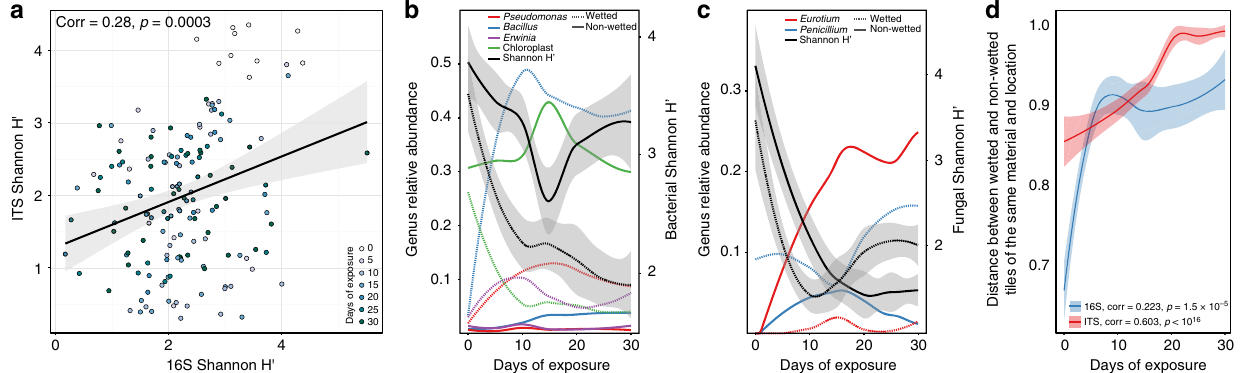
Fig. 3 Overview of community succession. a Fungal diversity and bacterial diversity are signi fi cantly correlated across communities ( n = 153 samples). Points represent individual samples, colored by the time point at which the sample was taken. b Changes in the relative abundance of selected bacterial genera over the course of succession ( n = 338 samples). Lines represent a smoothed moving-average of the mean. Genus is indicated by color and wetting condition is indicted by line style. Average community diversity (Shannon H ′ at OTU level, as in Fig. 3) is indicated by black lines with standard error indicated by the gray-shaded region. Genus abundance is indicated on the left y -axis and Shannon H ′ is indicated on the right y -axis. c Changes in the relative abundance of selected fungal genera over the course of succession ( n = 330 samples). Formatting is as in b . d Wet vs. nonwetted replicates of coupons of the same material and inoculating location become increasingly dissimilar over the course of community succession ( n = 338, 330 samples for 16S and ITS, respectively). The y -axis is the Bray − Curtis distance between replicates. Spearman correlation between community dissimilarity and time is indicated in the legend